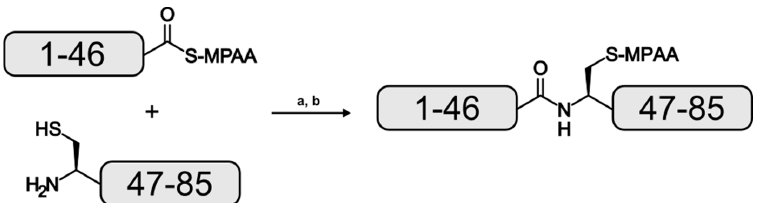
Figure 2. Reaction scheme for the formation of the EqtII(1–85) analogue. ( a ): pH 7, 20 °C, 18 h; ( b ): reversed-phase high performance liquid chromatography (RP-HPLC).